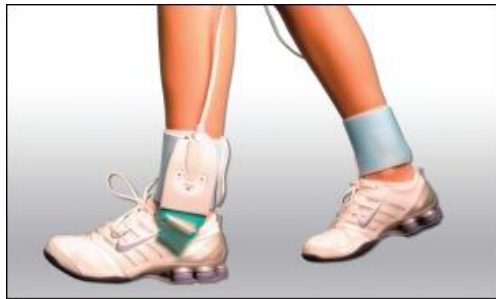
Figure 4. An in-shoe based foot plantar pressure sensor F-Scan ® System by Tekscan